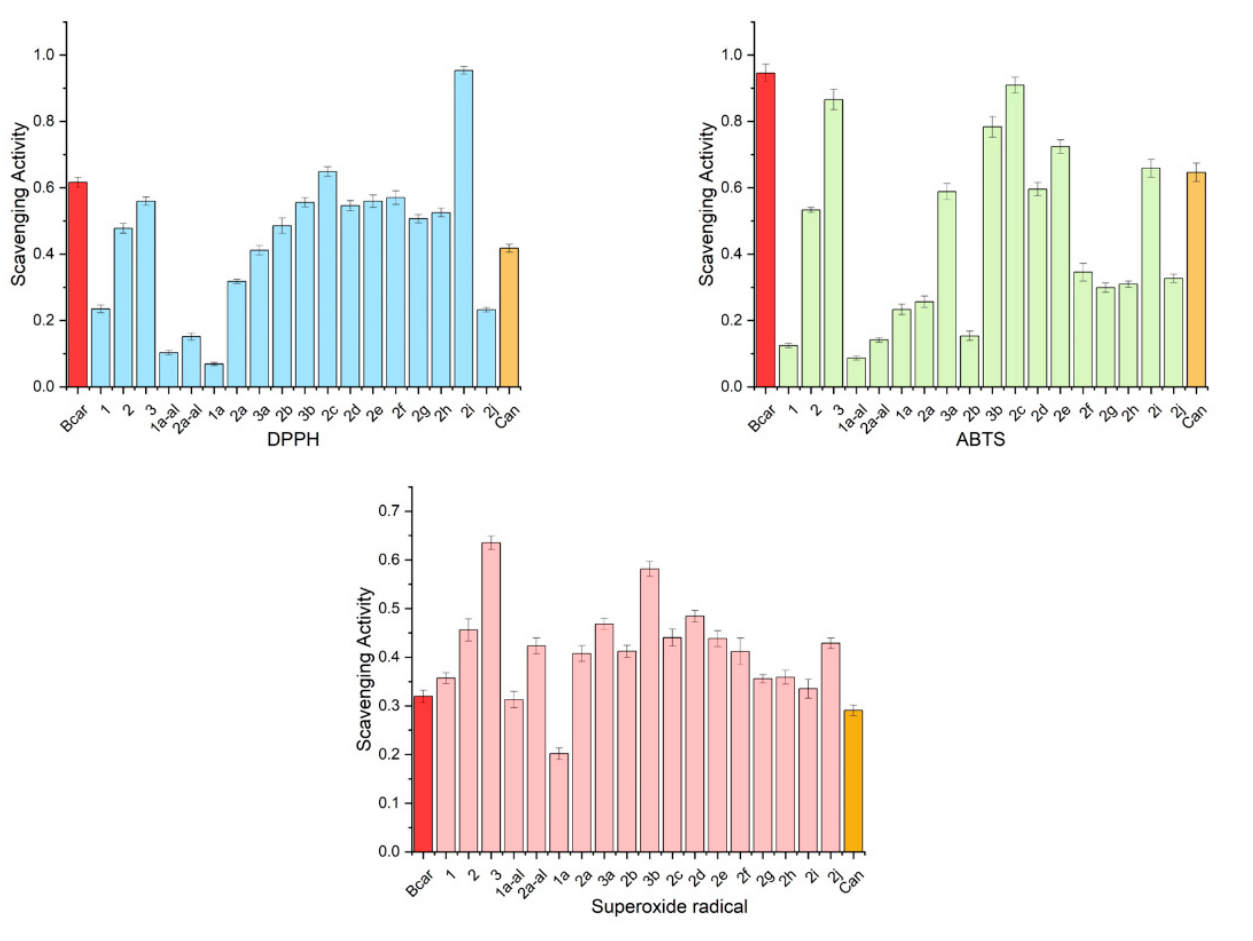
Figure 3. Antioxidant activity of oxo-carotenoids by the scavenging activity for DPPH, ABTS, and Superoxide radicals.